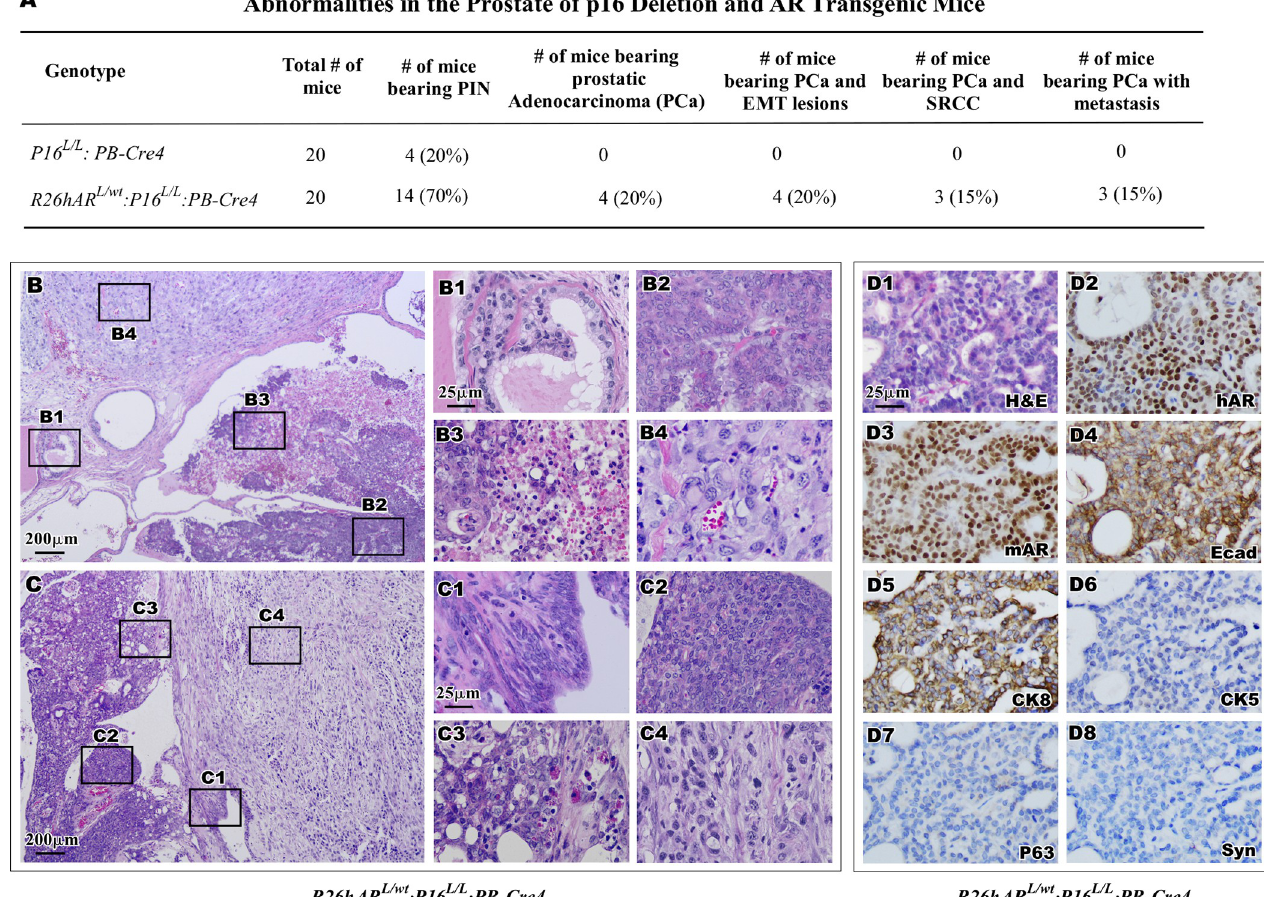
Fig 3. Synergistic effect of conditional AR expression and p16 Ink4a deletion accelerates formation of adenocarcinoma. ( A) Pathological abnormalities of the prostate were listed for both p16 L/L : PB-Cre4 and R26hAR L/wt : p16 L/L : PB-Cre4 mice. (B-C) Representative image of prostatic tumors from R26hAR L/wt : p16 L/L : PB-Cre4 mice. Scale bar used was at 200 μ m. B1-C4. Pathological dissemination of typical morphological characteristics of HGPIN (B1, C1) adenocarcinoma (B2, C2 and C3) and regions of necrosis (B3) and sarcomatoid carcinoma (B4, C4). D1-D8. Representative H&E and IHC images of adjacent prostate tissue sections of adenocarcinoma lesions from the R26hAR L/wt : p16 L/L : PB-Cre4 mice were shown for staining with different antibodies (right bottom corner). Scale bar used was at 25 μ m for all panels (B1-D8).